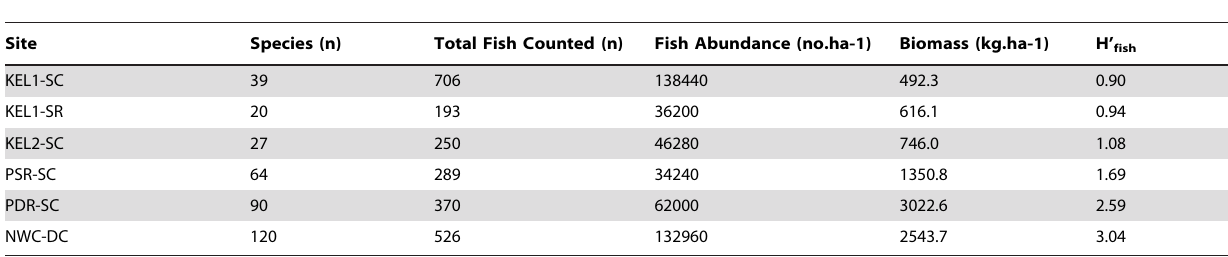
Table 4. Fish census